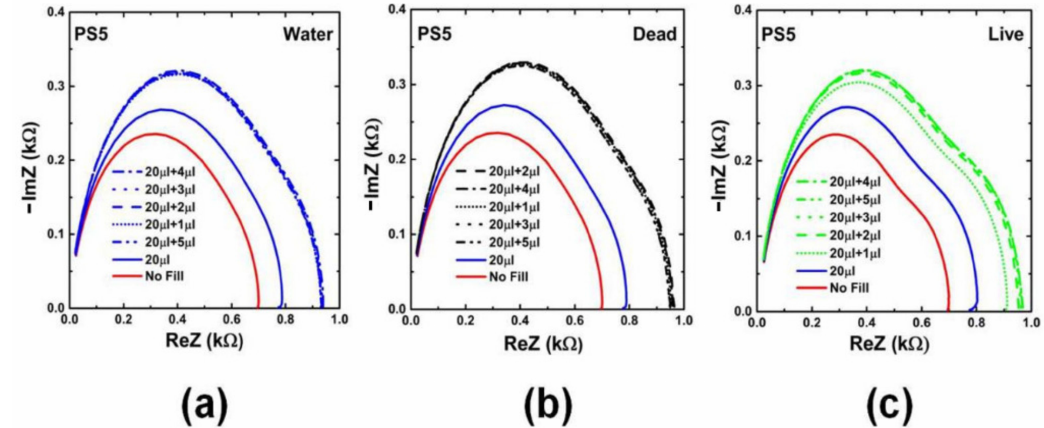
Figure 4. Nyquist plots for measured impedance of impedance chip PS5 (Table A1) without filling (No fill, red solid line), with filling with DI water (20 µ L, blue solid line), and with addition of 1 µ L (OD8.5) (20 µ L + 1 µ L), 2 µ L (OD8.5) (20 µ L + 2 µ L), 3 µ L (OD8.5) (20 µ L + 3 µ L), 4 µ L (OD90.0) (20 µ L + 4 µ L), and 5 µ L (OD90.0) (20 µ L + 5 µ L) ( a ) DI water (blue scattered lines) ( b ) Dead cells (black scattered lines) and ( c ) Live cells (green scattered lines). The corresponding concentration of live and dead cells is given in Table